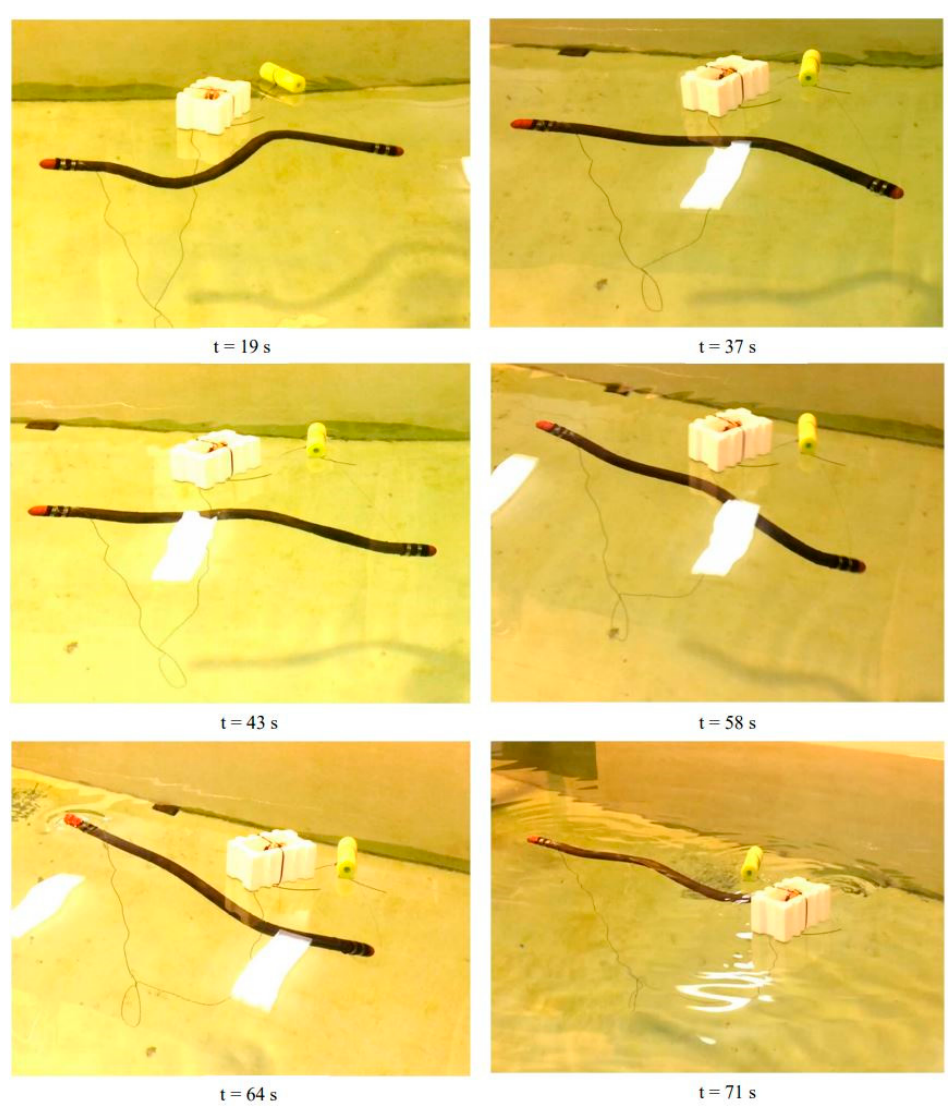
Figure 16. Swimming test of NEELBOT 1.2 with expanding/retracting dome conducted in the towing tank.